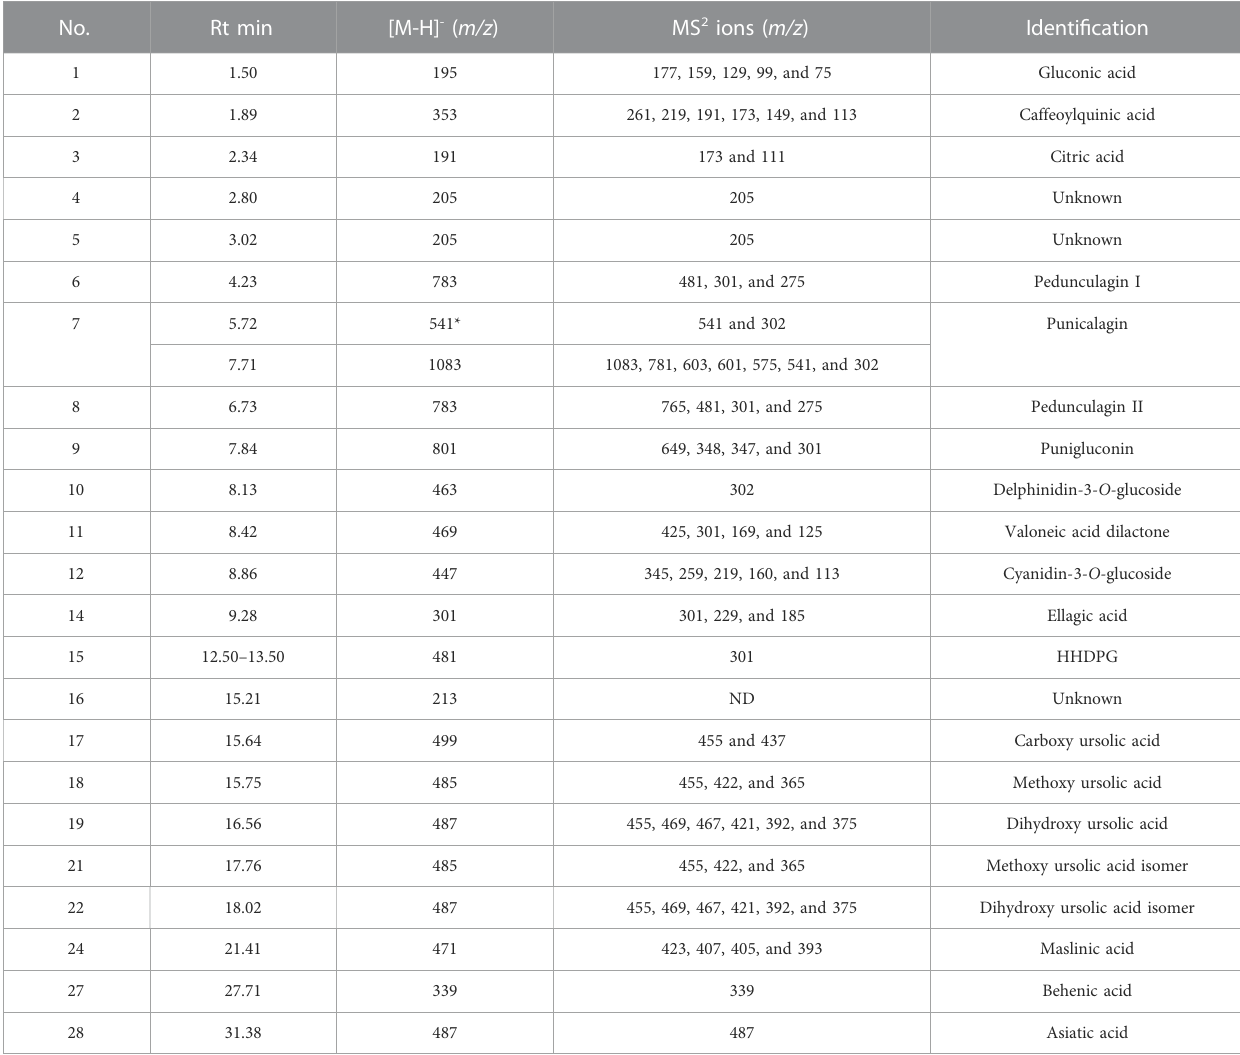
TABLE 1 UPLC-PDA-MS/MS analysis results of pomegranate peel extract (PPE).